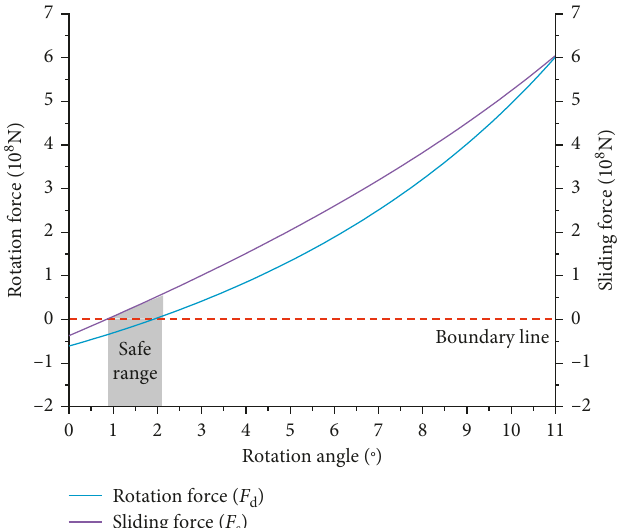
Figure 7: Relationship between sliding force, rotation force, and rotation angle of Section B-B (view of the key block).